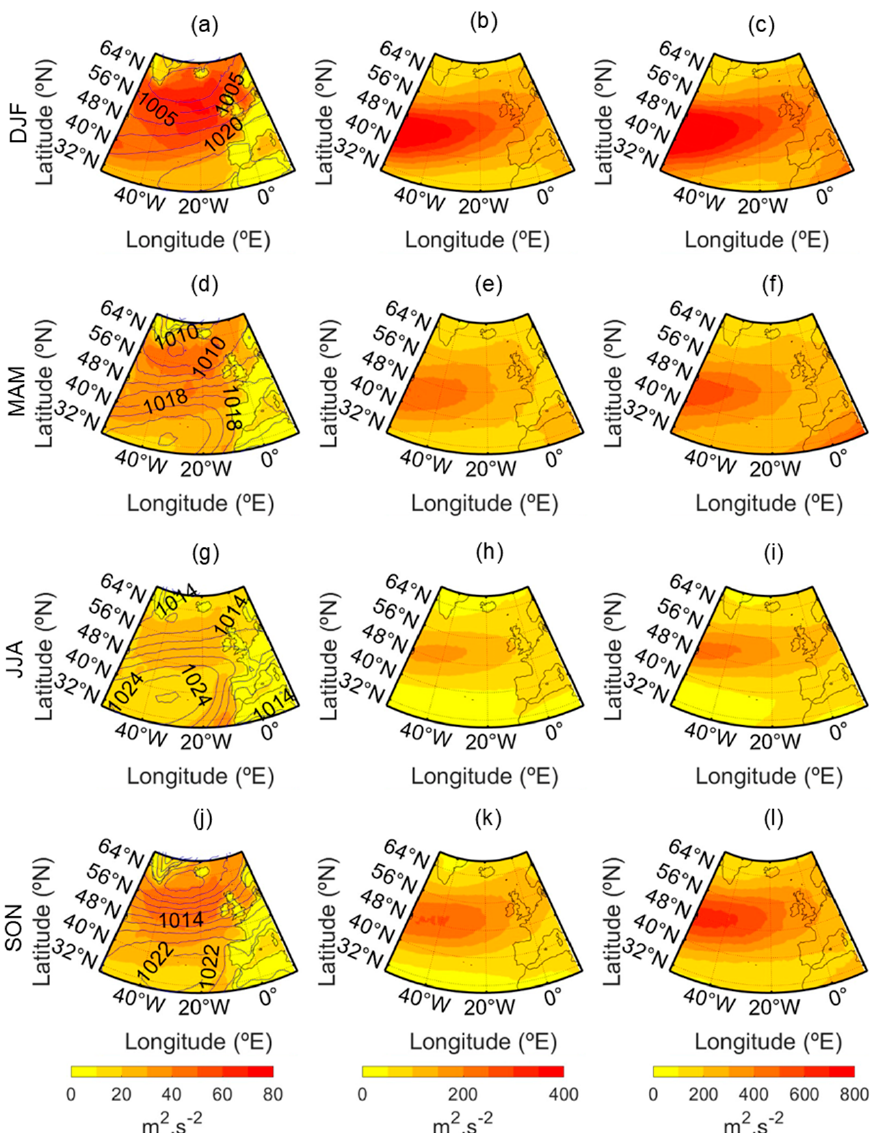
Figure 3. Seasonal (winter: DJF, spring: MAM, summer: JJA, and autumn: SON) median of KE (m 2 /s 2 ) for the reference period (1995–2014), at 10 m (left column ( a , d , g , j )), 500 hPa (middle column ( b , e , h , k )) and 250 hPa (right column ( c , f , i , l )) levels. Black lines in the left column panels correspond to the isobars (in hPa).